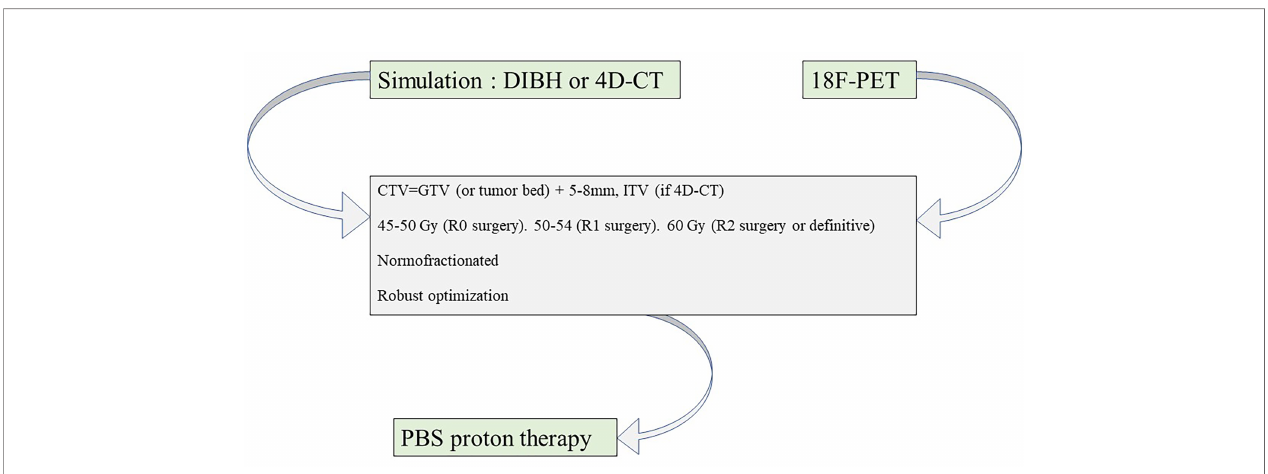
FIGURE 1 | Proton therapy planning for thymic epithelial tumor irradiation. CT, computed tomography; 18 F-PET, fl uorodeoxyglucose F18 positron emission tomography; DIBH, deep-inspiration breath hold; PBS, pencil beam scanning; GTV, gross target volume; ITV, internal target volume; CTV, clinical target